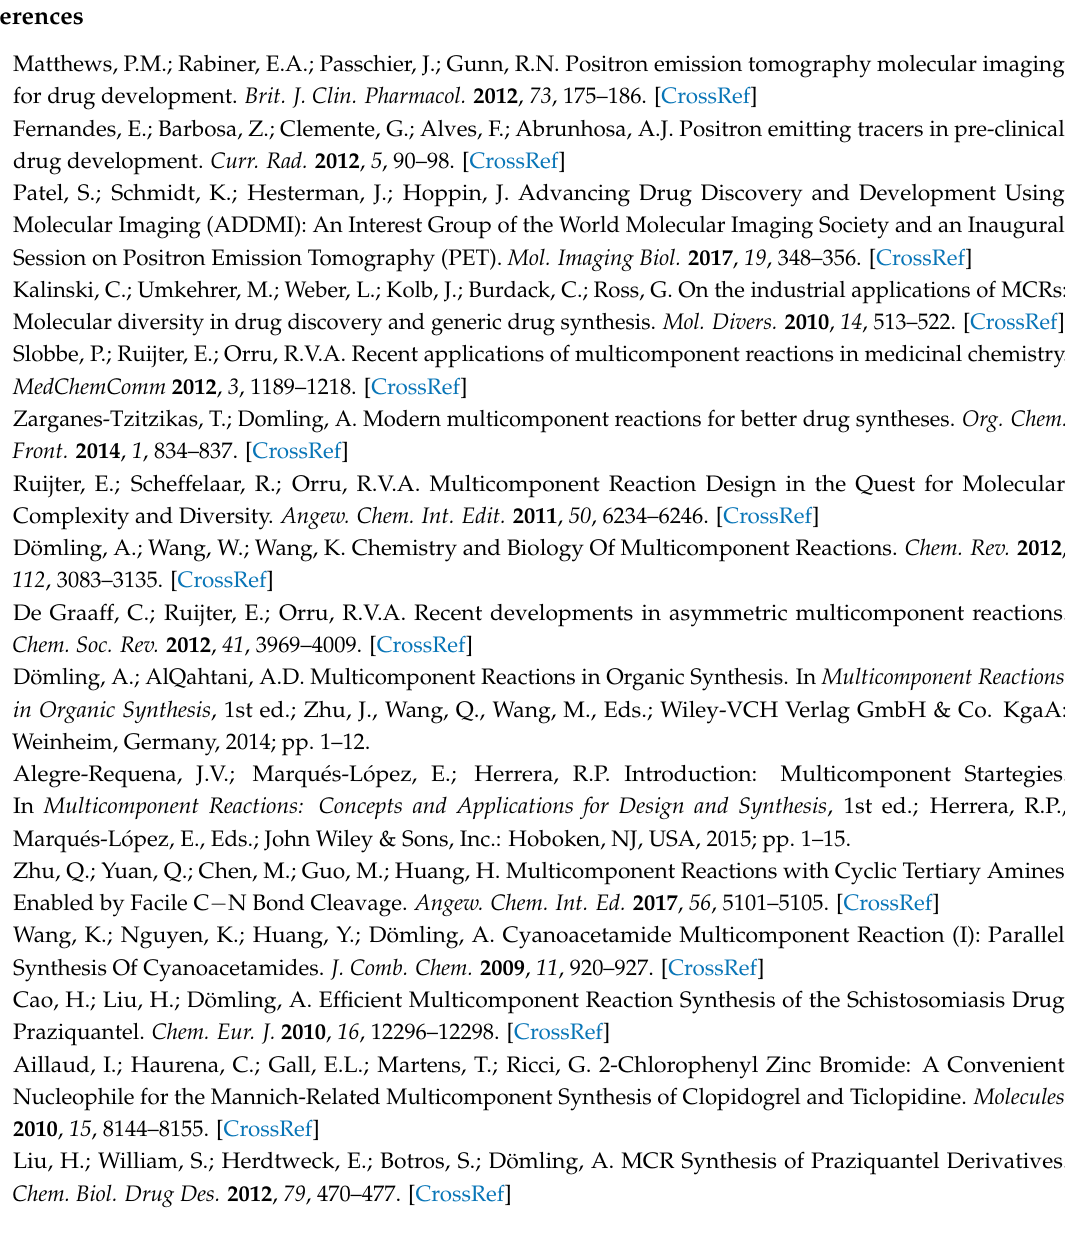
Table S1: TLC-SG retention factor (Rf) profiles for the tested compounds; Figure S14: Effect of temperature in